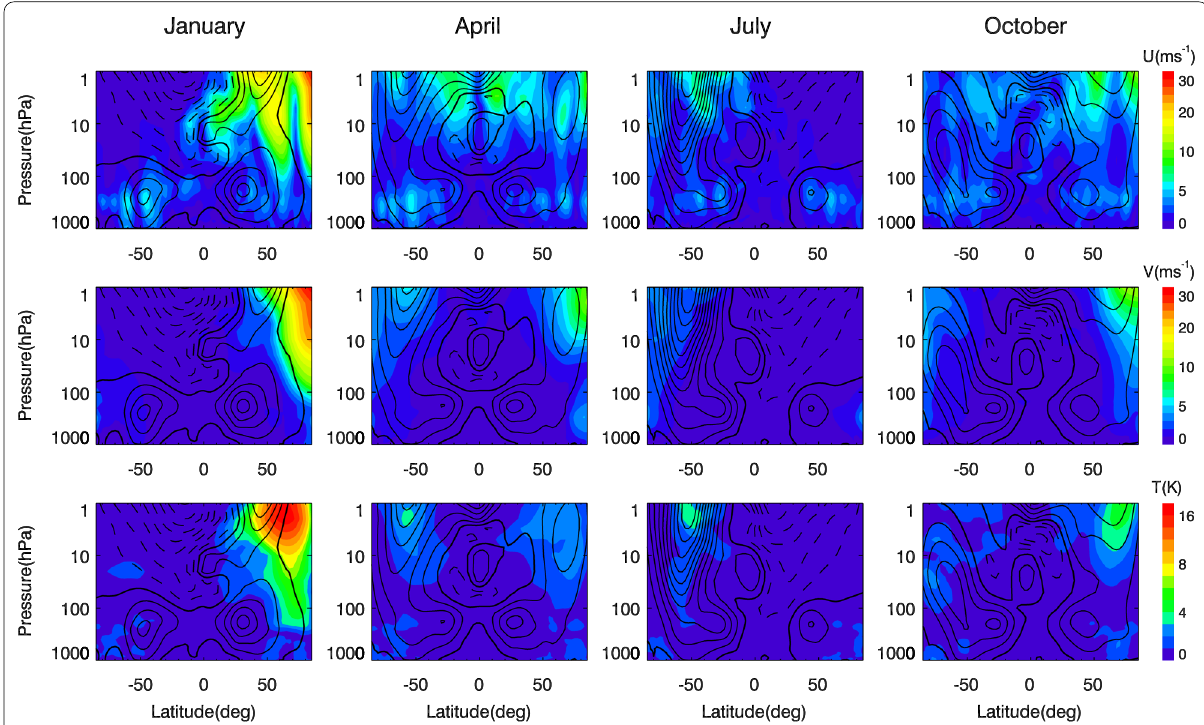
Fig. 2 Altitude versus latitude structures of the W1 Q16DW amplitudes for the zonal wind (top), meridional wind (middle) and temperature (bottom) in January (first column), April (second column), July (third column) and October (last column). In addition, the monthly averaged zonal-mean zonal winds are plotted as contour lines (solid and dashed contour lines represent the eastward and westward winds, respectively, and the thick lines represent zero wind lines) in these months for reference, and the intervals of the contour lines are 10 ms −